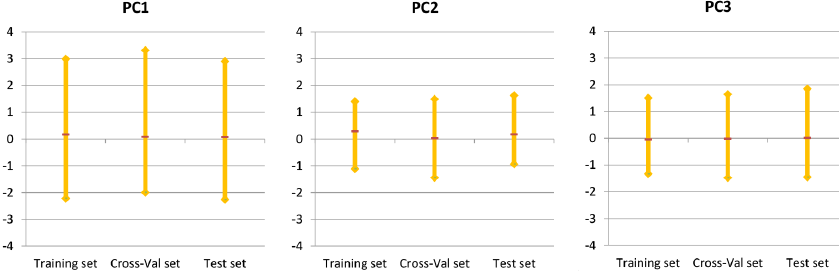
Figure 2. Mean value (red dash) and the bars comprised between the 90th and 10th percentiles of the resulting training, cross-validation and testing sets for each of the three input variable (PC1, PC2 and